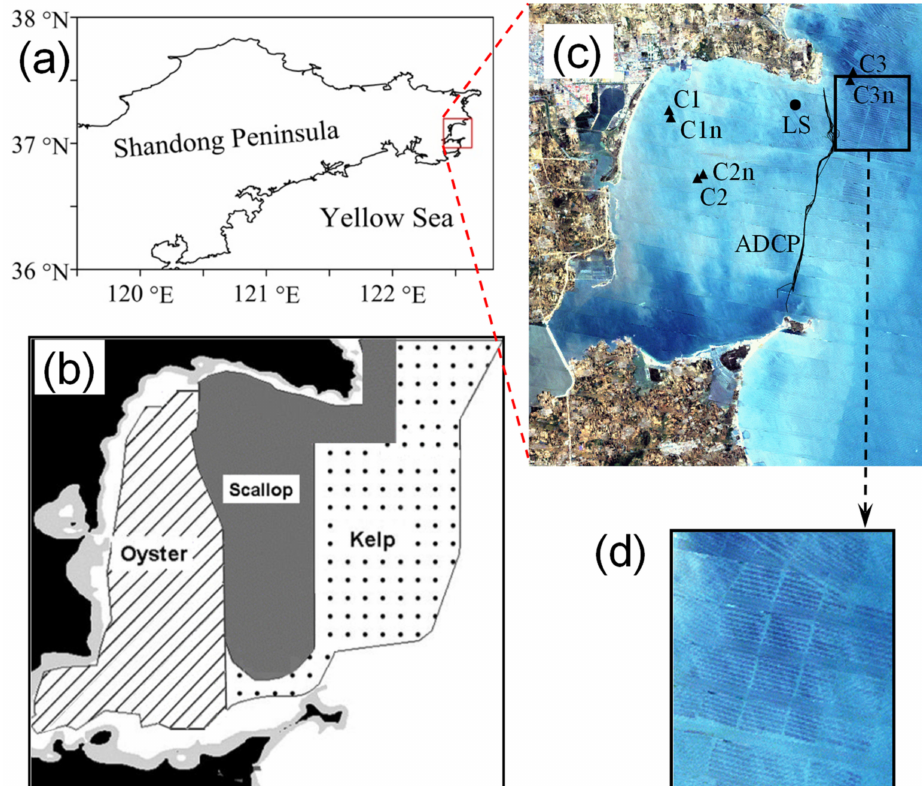
Figure 1. Sketch of Sungo Bay: ( a ) location of bay; ( b ) aquaculture areas for oysters, scallops, and kelp (adapted from [27] with permission from Elsevier, 2022); ( c ) observation locations. LS ( • ) is the water-level observation station; ( (cid:78) ) marks sites C1 and C2 (in oyster-culture zones), C3 (in scallop-culture zone), and C1n, C2n, and C3n near them (out of the culture zone) for water-current observation; round-route curves indicate observations of currents by ADCP at the bay mouth; ( d ) the enlarged square image (from Landsat) shows a sky view of aquaculture rafts for